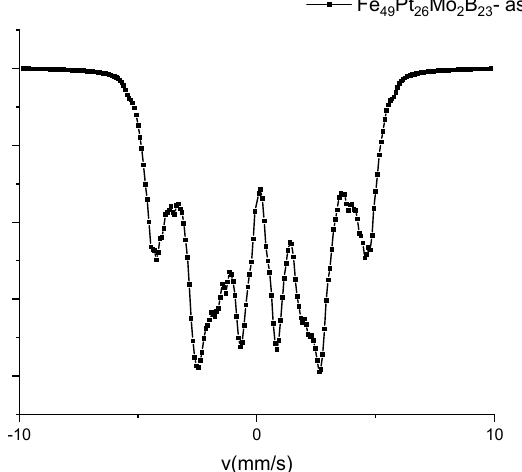
Figure 4. 300 K Mössbauer spectrum of the as-cast sample.